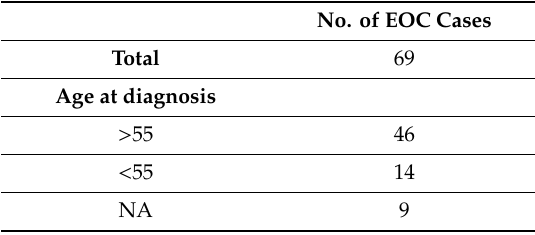
Table 1. Distribution of tumor characteristics for EOC (Epithelial ovarian cancer) patients with evidence of